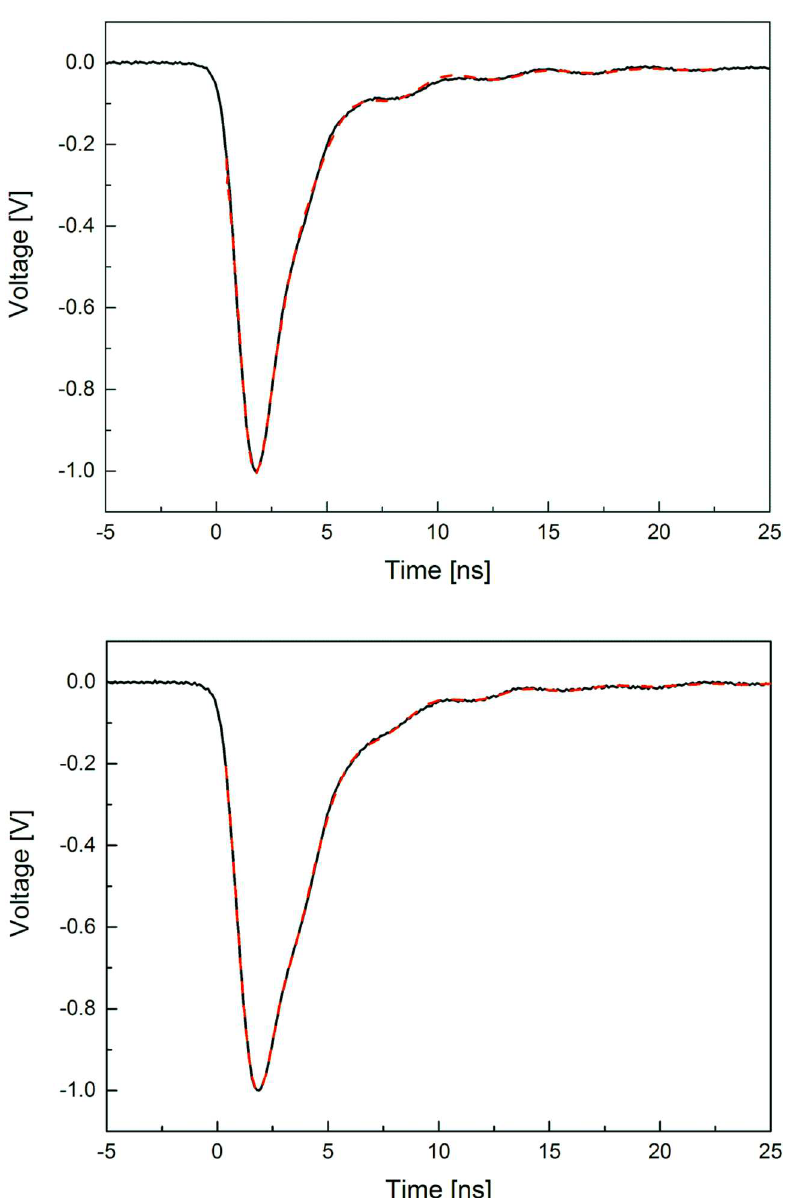
Fig 10. Averaged signals from photomultiplier connected to BC-420scintillator (top) and to J-PET scintillator (bottom). Red dashedline indicatesresult of fitting a function given by the sum of Formulas (2) and (3). Signals were normalized to the amplitudeequal to 1V.